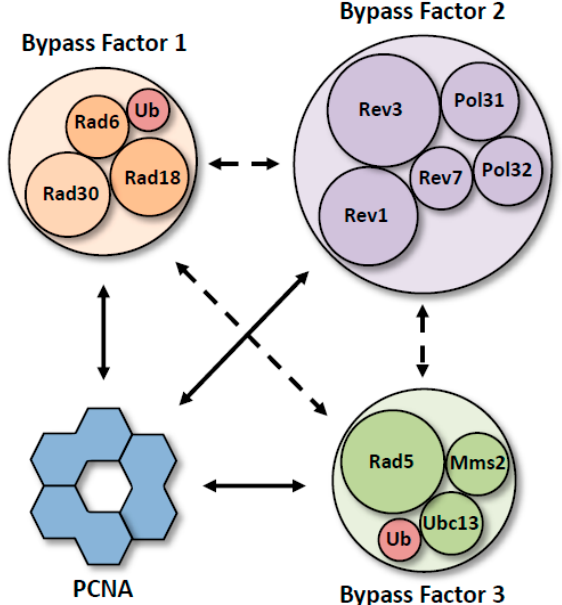
Figure 5. Composition of the putative bypass factors. Diagrams showing the protein components of putative Bypass Factor 1 (orange) containing pol η (Rad30), Bypass Factor 2 (purple) containing pol ζ (Rev3–Rev7–Pol31–Pol32), and Bypass Factor 3 (green) containing Rad5. Ubiquitin moieties are shown in red. Solid arrows represent direct interactions with PCNA that allow for the formation of PCNA tool belts. Dashed arrows represent interactions that allow for the formation of alternative architectures.